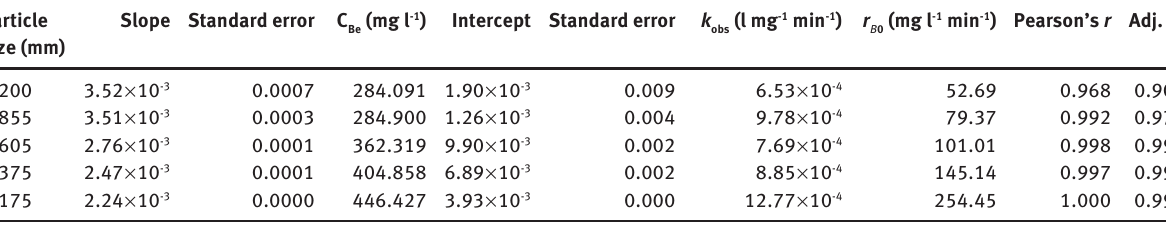
Table 4: Second-order kinetic model for the isothermal green solid-liquid extraction of andrographolide at 80 ° C from Andrographis panicu- lata (AP) for different particle sizes and solid-liquid ratio of 1:10 (g ml -1 ). Particle